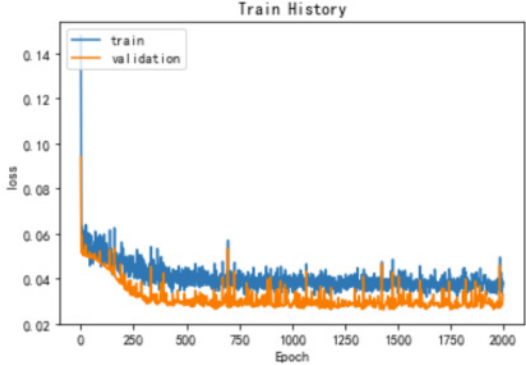
Figure 11. A320 Variation of iteration number error. Figure 11. A330 Variation of iteration number error.